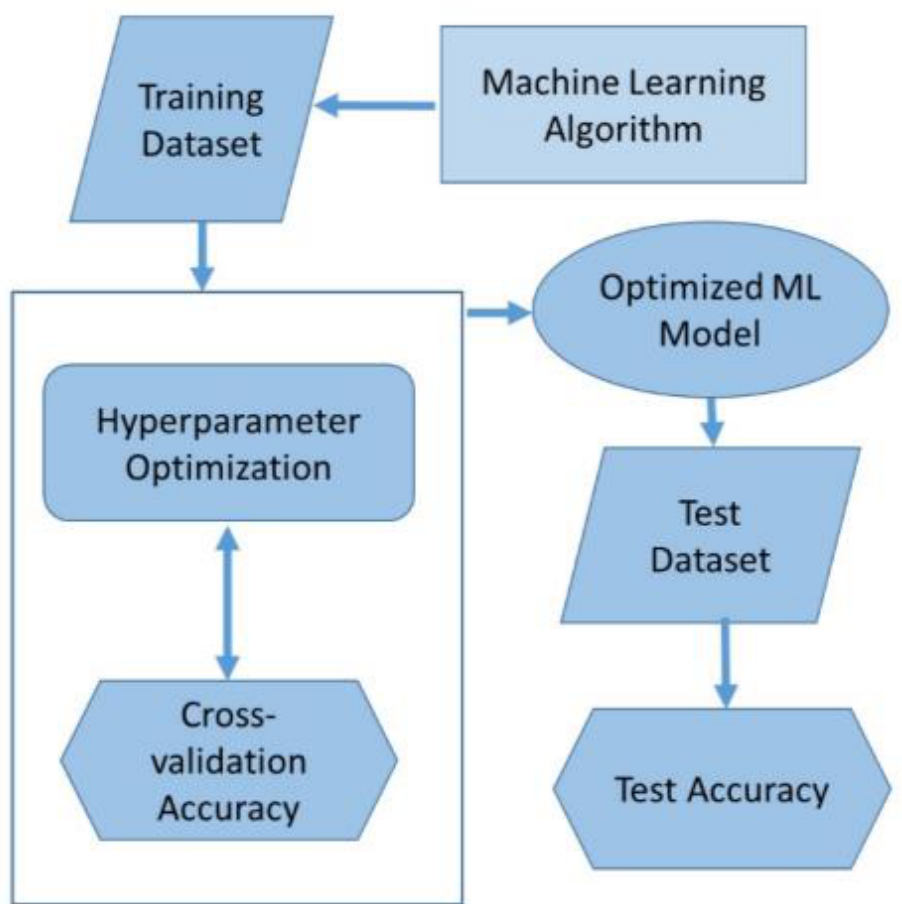
Figure 7. General framework of ML classification system.